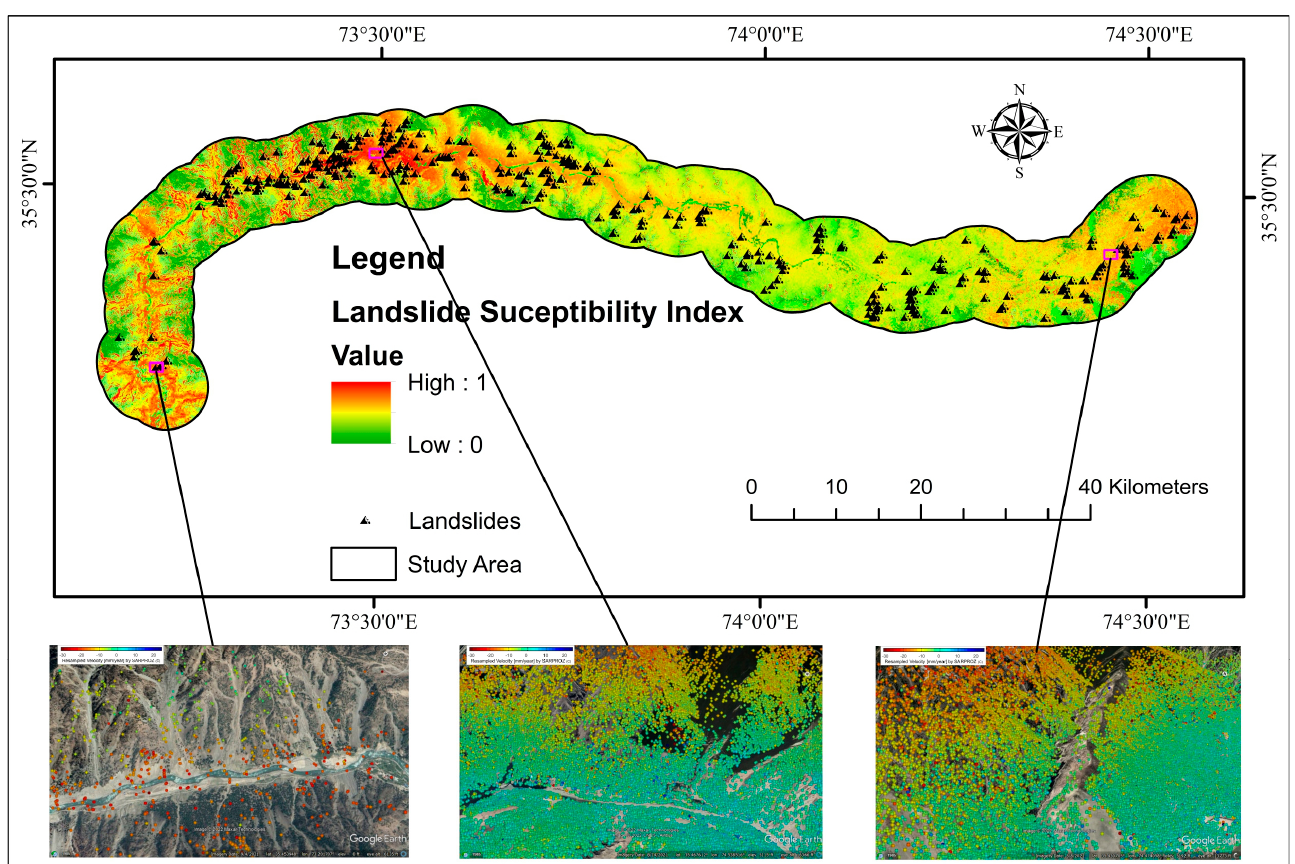
Figure 14 . PSI distribution of LOS deformation velocity on Google Earth using RF landslide susceptibility index.